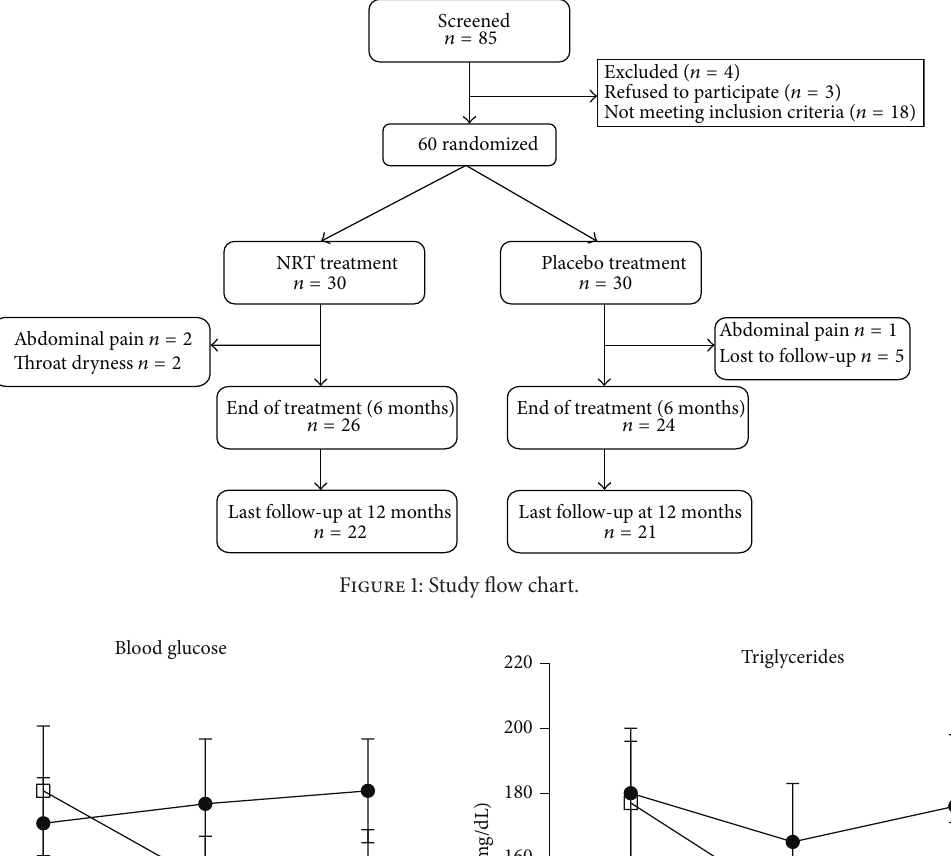
Figure 1: Study flow chart.